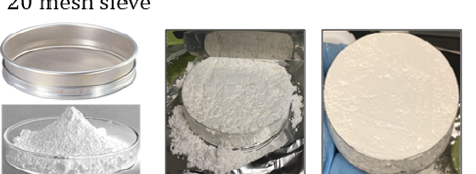
Fig. 3. Preparation of powder bed for quantifying bed packing density